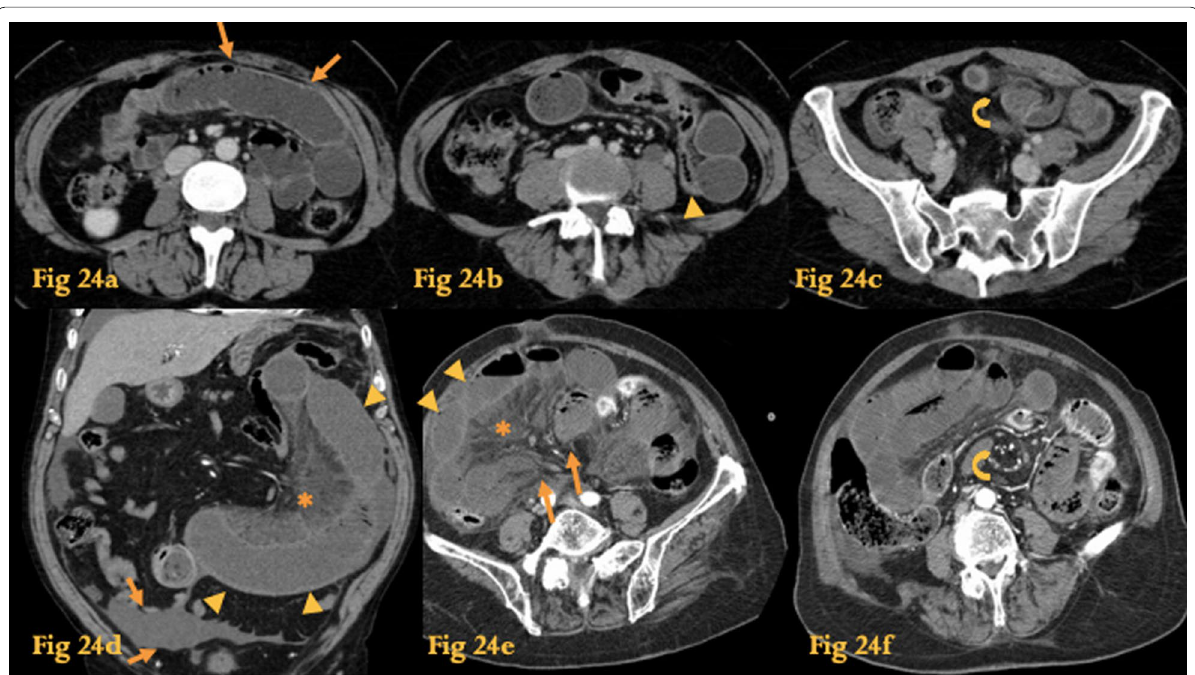
Fig. 24 Internal hernia. Abdominal CT of a patient with a left paraduodenal internal hernia there is no fat between the fluid‑filled dilated small bowel loop and the anterior abdominal wall (arrows on a ). The small bowel loops are seen lateral to the descending colon with medial deviation of the colon (arrowhead on b ). There is twisting of the bowel loops and mesentery—whirl sign (curved arrow on c ). Another patient with CT findings of a right paraduodenal internal hernia fluid‑filled dilated loop of small bowel with a U/C‑shape configuration which represents a closed loop obstruction ( d ). Both ends of a fluid‑filled distended closed‑loop taper fusiformly, in a similar way to a beak—the beak sign (arrows on e ). There is also twisting of the mesenteric vessels at the mesenteric root—whirl sign (curved arrow on f ). The fact that there is diminished enhancement of the bowel wall (arrowheads), densification of the mesentery (asterisk) and free fluid (arrows) suggests strangulation ( d